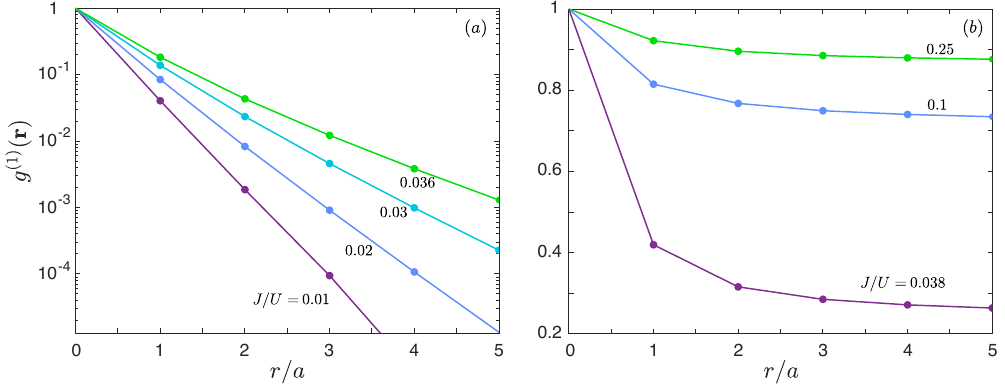
( 1 ) ( r ) for d = 2 and U / U = 0.9 evaluated 12 i